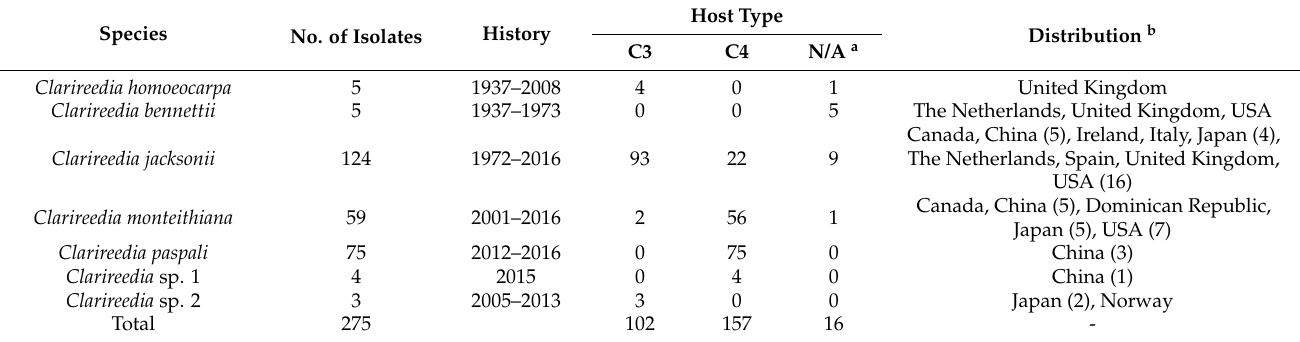
Host Type Distribution b C3 C4 N/A a